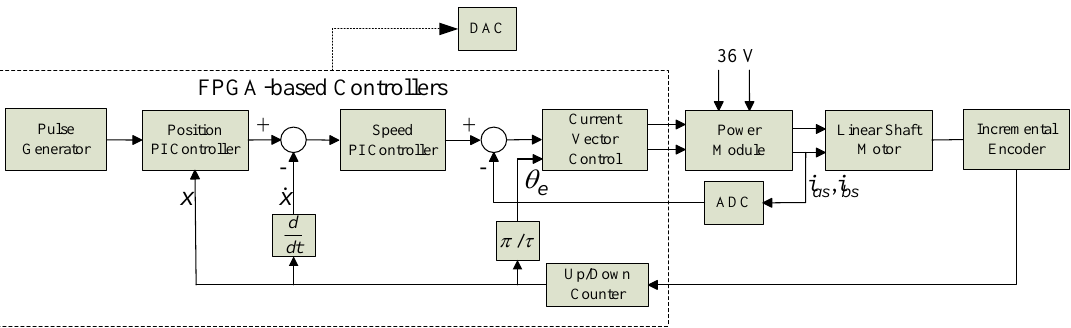
Figure 2. The functional block diagram of linear shaft motor drive system.